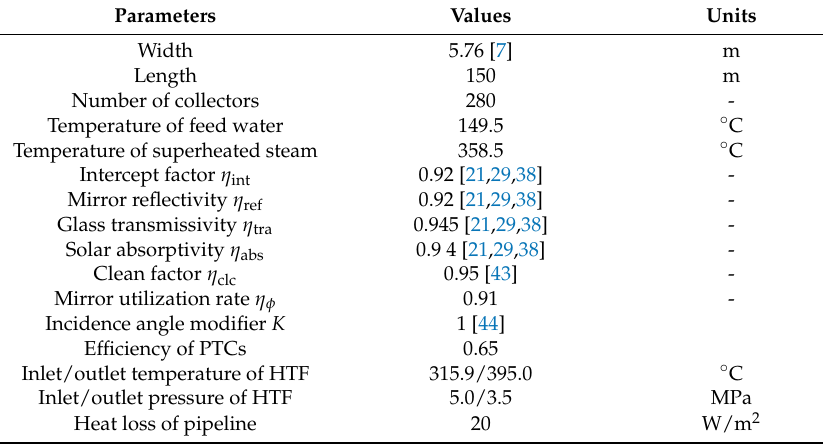
Table 3. Main parameters of parabolic trough solar